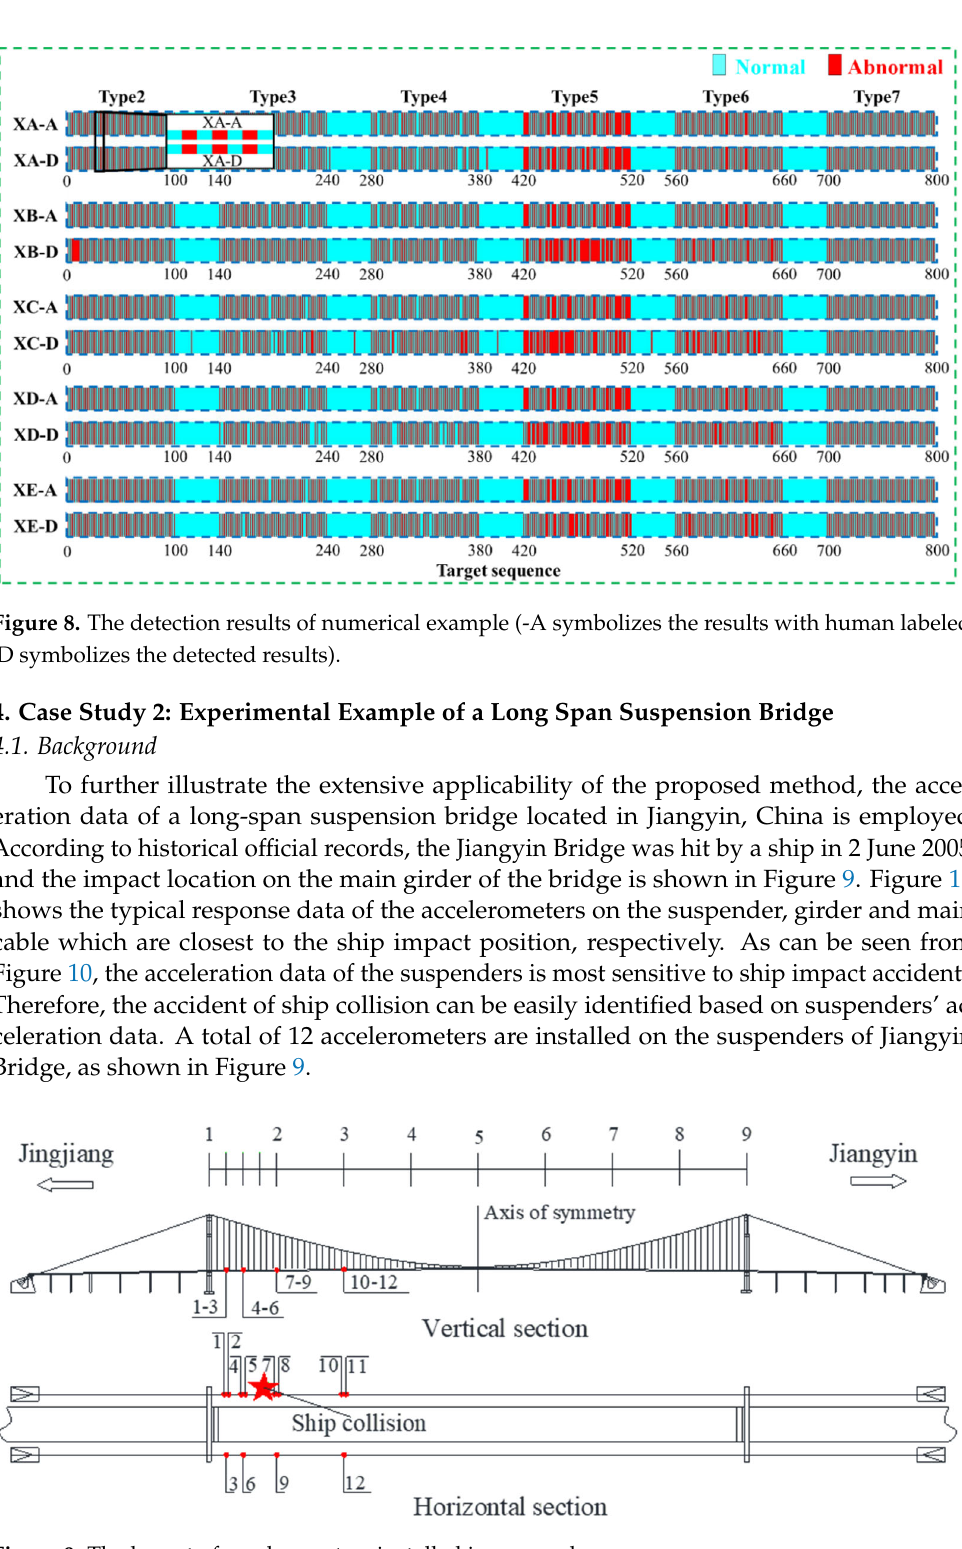
Figure 7. The precise (P), recall (R) and accuracy (A) of the detection results.